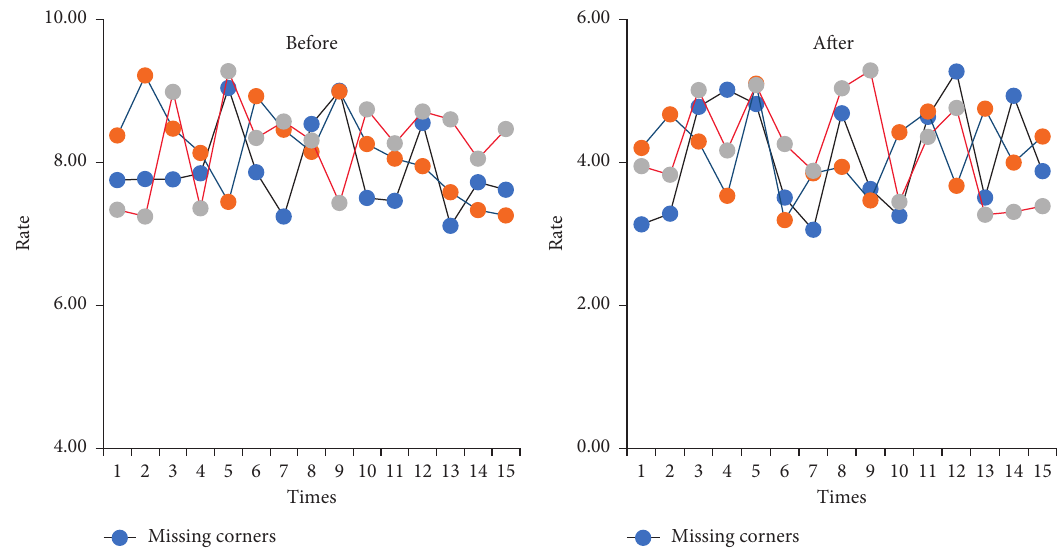
Figure 7: Overview of alumina